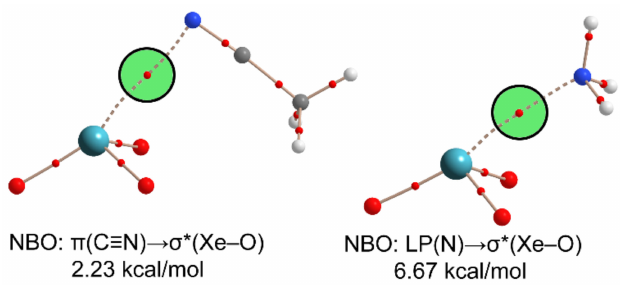
Figure 4. Distribution of bond critical points (in red) and bond paths in the XeO 3 ··· NCCH 3 ( left ) and XeO 3 ··· NH 3 ( right ) complex. The results from the Natural Bond Orbital (NBO) analysis are also indicated close to the complexes. LP stands for lone